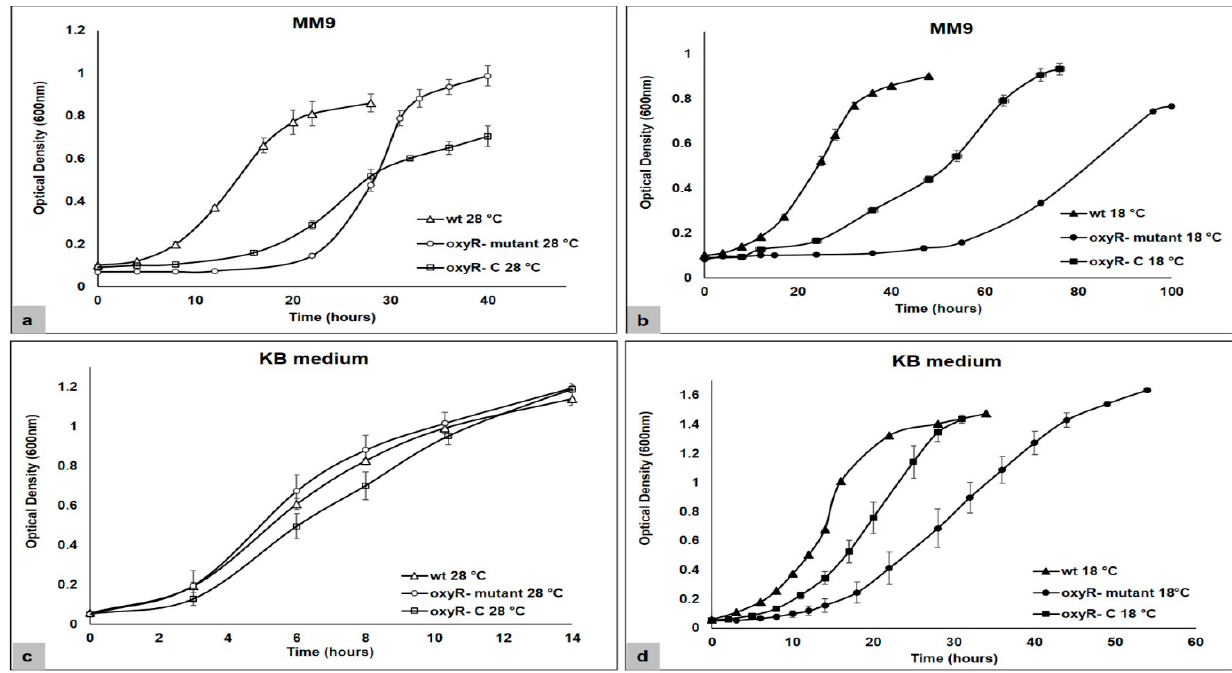
Figure 1. Growth curves of the wt, oxyR-mutant , and oxyR- C (complemented mutant) strains of P. savastanoi pv. phaseolicola NPS3121. ( a ) Bacterial growth curves at 28 °C in MM9. ( b ) Bacterial growth P. savastanoi pv. phaseolicola NPS3121. ( a ) Bacterial growth curves at 28 ◦ C in MM9. ( b ) Bacterial curves at 18 °C in MM9. ( c ) Bacterial growth curves at 28 °C in KB medium. ( d ) Bacterial growth growth curves at 18 ◦ C in MM9. ( c ) Bacterial growth curves at 28 ◦ C in KB medium. ( d ) Bacterial curves at 18 °C in KB medium. growth curves at 18 ◦ C in KB